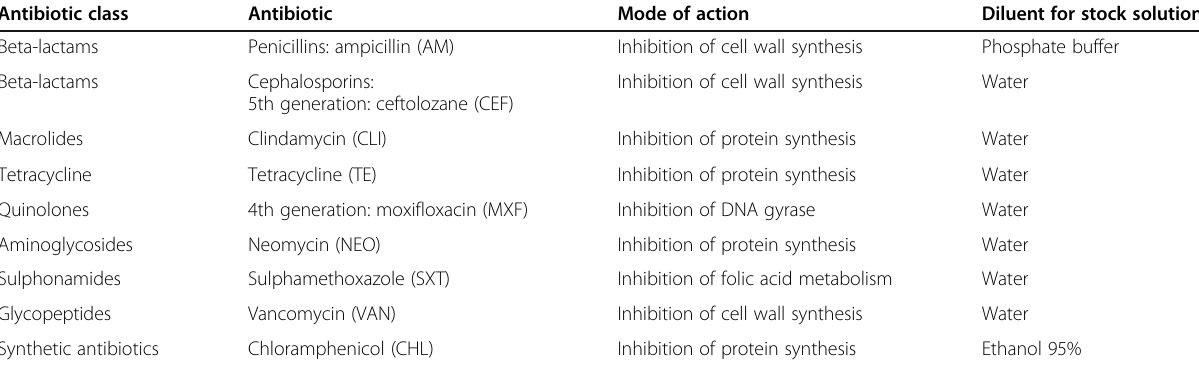
Table 1 Selected antibiotics to evaluate the antibiotic susceptibility of isolated LAB Antibiotic